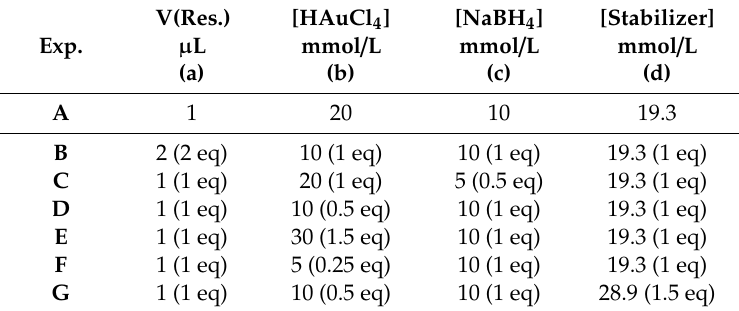
Table 1. Overview of the experimental conditions of the experiments A–G.